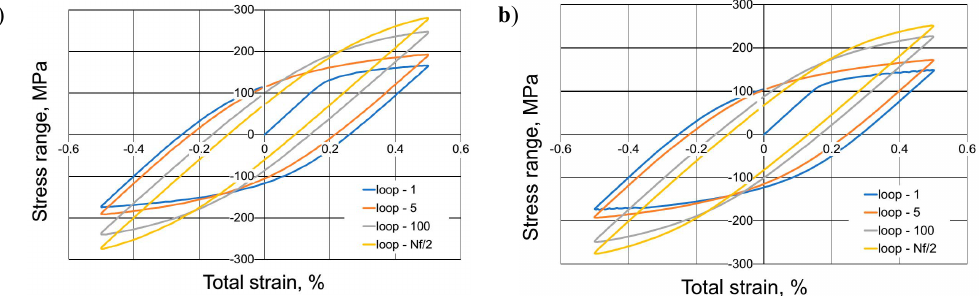
Figure 8. Examples of hysteresis loops for 0.5% total strain range: base material ( a ) and FSW joint ( b